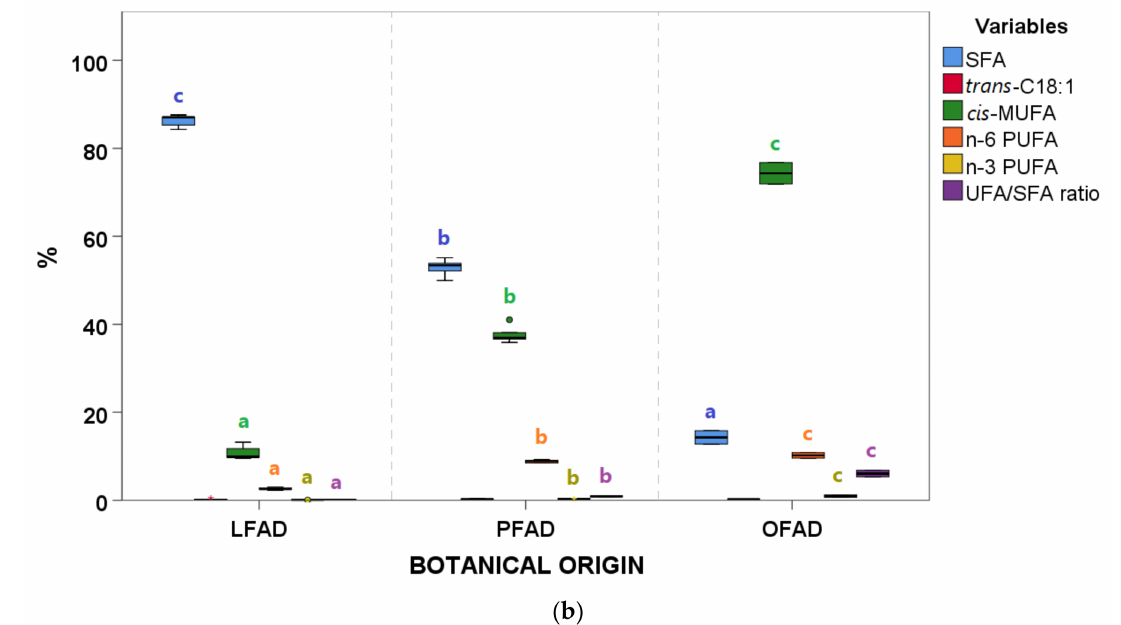
Figure 4. Saturated fatty acids (SFA), trans-C18:1, cis-monounsaturated fatty acids (cis-MUFA), polyunsaturated fatty acids (n-6 and n-3 PUFA), and boxplots according to botanical groups for ( a ) acid oils (AO) from chemical refining ( n = 79) and ( b ) fatty acid distillates (FAD) from physical refining ( n = 13) (see Table 1 for abbreviations of botanical groups). Within each type of byproduct (AO or FAD) and variable, botanical groups bearing different letters (a–e) show significantly different medians ( p ≤ 0.05) according to Kruskal–Wallis test and stepwise multiple comparisons for independent samples. Tables S2 and S3 in the Supplementary Materials report the numeric results of the FA composition. ◦ Outliers: samples with values between (Q3 + 1.5 × IQR) and (Q3 + 3 × IQR) or between (Q1 − 1.5 × IQR) and (Q1 − 3 × IQR).